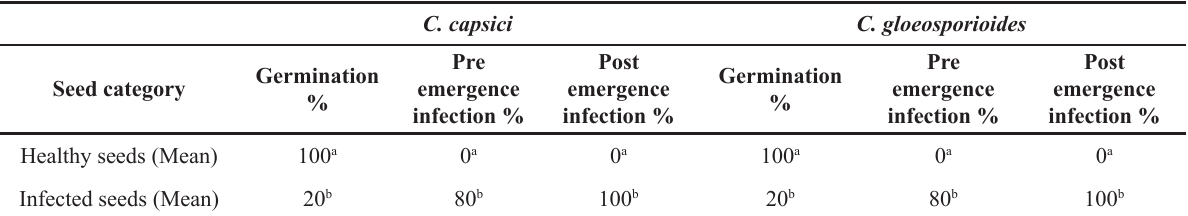
Values within a column and not followed by the same letter are significantly different at ( P <0.05) according to the Student’s t